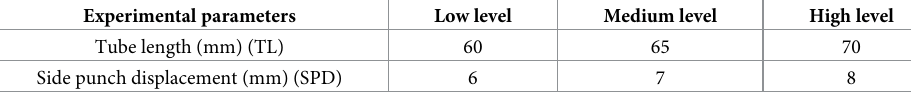
Table 2. Design of experiment (DOE) factor levels.